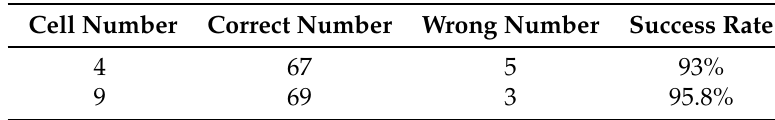
Table 2. The test result of the number of cells in a block.